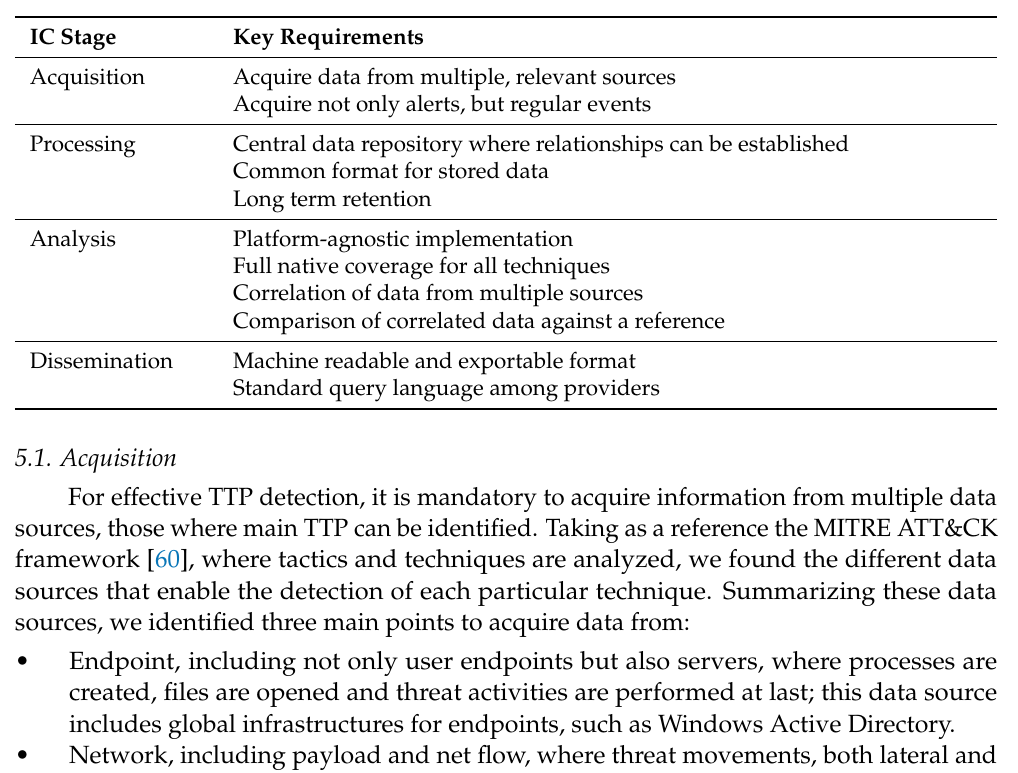
Table 3. Key requirements for TTP